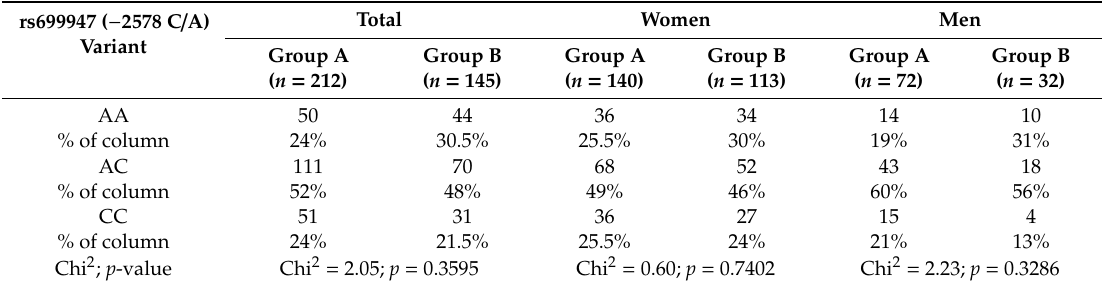
Table 3. Distribution of genotypes of rs699947 (2578 C / A) variant of VEGF gene.